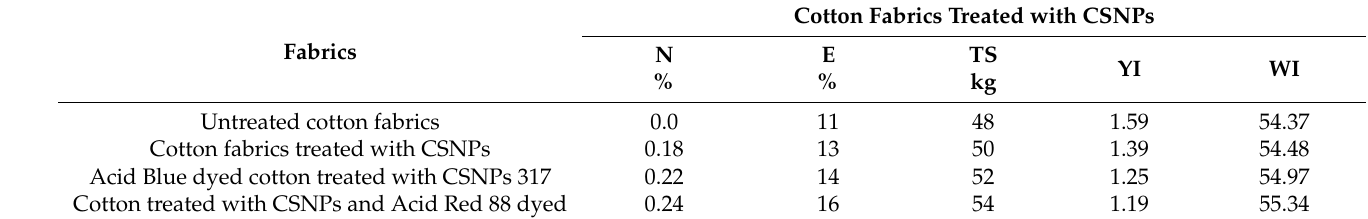
Table 1. Nitrogen content, mechanical properties, yellowness index, and whiteness index of untreated cotton fabrics, cotton fabrics treated with CSNPs, and cotton fabrics dyed with CSNPs.